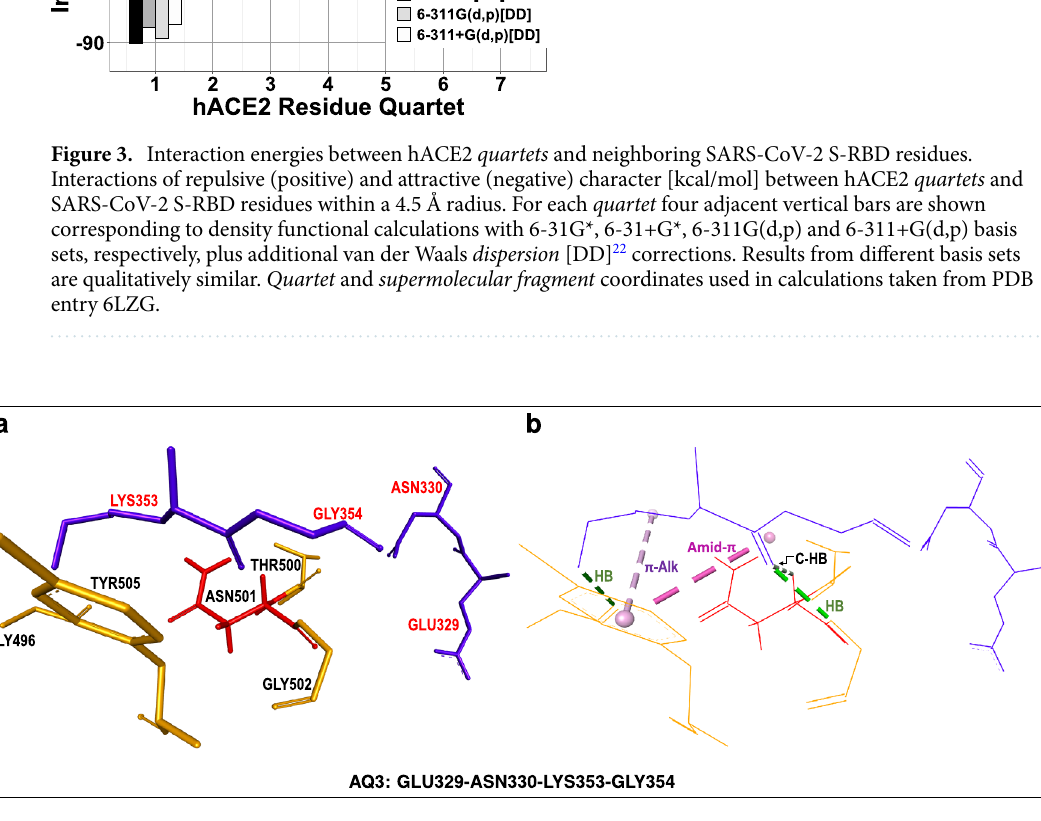
Figure 4. hACE2-centered supermolecular fragment giving rise to mixed, attractive and repulsive, hACE2...S- RDB interactions. ( a ) hACE2 quartet residue (shown in blue) and neighboring SARS-CoV-2 S-RBD residues (shown in gold). S-RBD[ASN501] is shown in red. ( b ) Selected intermolecular interactions corresponding to (i) conventional hydrogen bonds (HB) (dotted green lines), (ii) carbon (non-classical) hydrogen bond (C-HB) between LYS353 and ASN501 (dotted silver lines) and (iii) π -alkyl ( π -Alk) or amide- π interactions (dotted pink